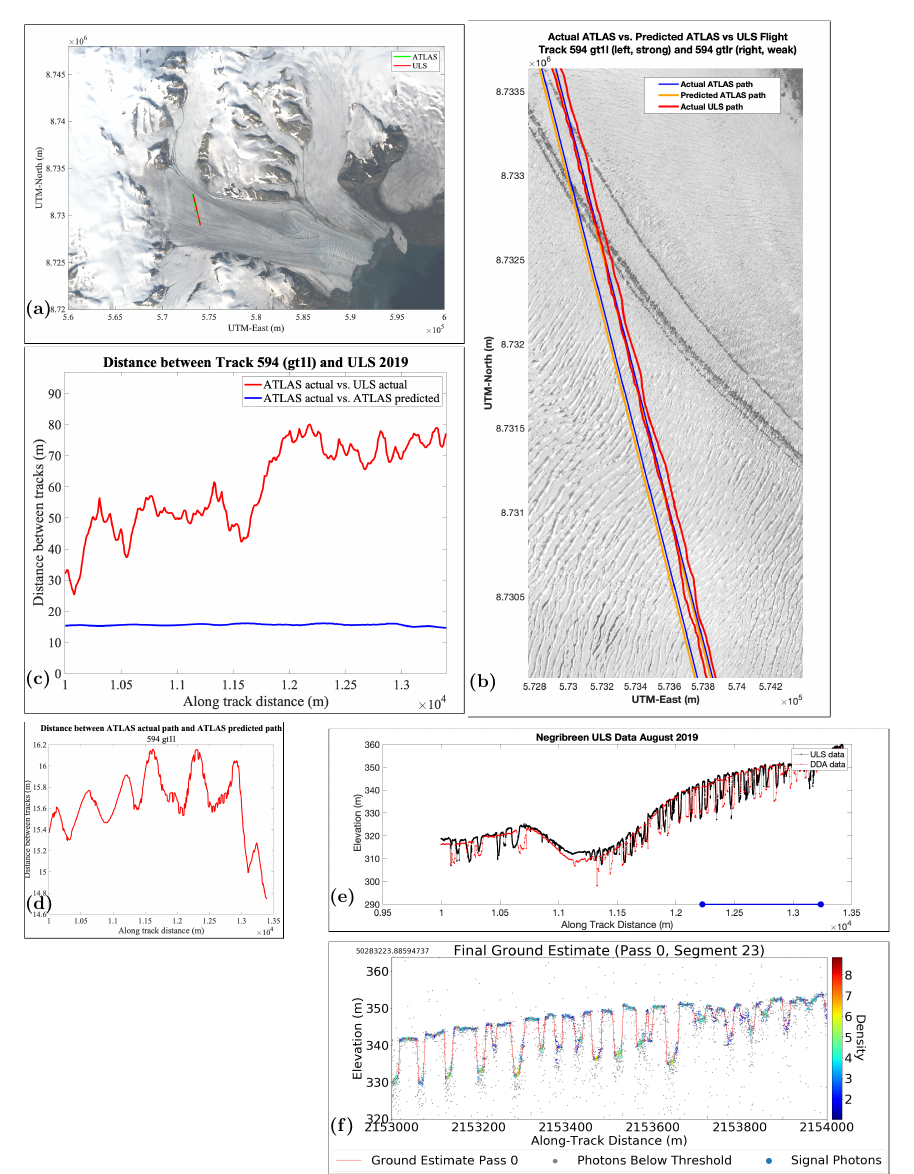
Figure 12. ICESat-2 ATLAS vs. ULS data. Track repeat accuracy and results. RGT 594, gt1l (strong). Negribreen validation campaign. Flight 2, 13 August 2019. ( a ) Location of DDA segments over Negribreen and closest ULS data. For segment numbering, see Figure 9 (ATLAS DDA segments). Background: Landsat-8 image from 5 August 2019 [LC08_L1TP_215003_20190805_20190820_01_T1]. Segment lengths in ( a , c – e ) are the same, segments in ( b , f ) are subsets. ( b ) Track separation between our ULS flight path, the ATLAS predicted flight path, and the ATLAS actual flight path for granule: [ATL03_20190805232841_05940403_002_01.h5]. Background: Planet SkySat image from 18 August 2019 [20190818_150858_ssc9_u0002_panchromatic_dn.tif]. ( c ) Separations between ATLAS Track 594 (gt1l) actual and ULS flight path, and between ATLAS Track 594 (gt1l) actual and ATLAS Track 594 (gt1l) predicted. Calculated for actual ATLAS and ULS flight paths from data shown in ( b ). ( d ) Track separation between predicted and actual ATLAS 594 (gt1l) flight paths; same segment length as in ( a , c ). ( e ) ULS surface heights and ICESat-2 ATLAS DDA-ice surface heights superimposed, after GPS and IMU correction of ULS paths (ground locations). Blue line: Section covered in f. ( f ) ICESat-2 ATLAS surface heights over crevassed region derived using DDA-ice, RGT 594, gt1l, segment 23. DDA-ice parameters as in Table 2. ATL03 data set given in caption for ( c ). Rel. 03 data (see,